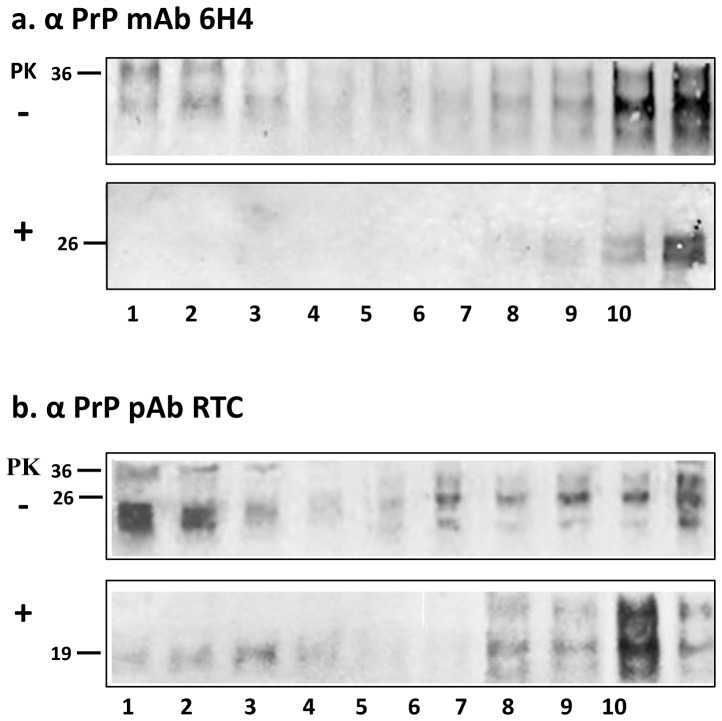
Disease related PrP forms in brains from E200K gCJD patients.Sarkosyl extracted brain homogenates from E200K CJD patients were subjected to ultracentrifugation in 10–60% sucrose gradients. Individual fractions were digested with PK and immunoblotted with: (a) α-PrP mAb 6H4 and (b) α-PrP pAb RTC.